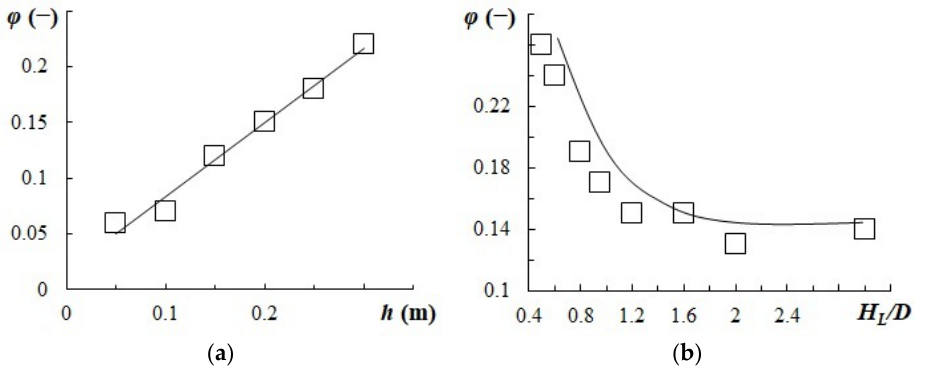
Figure 10. Dependence of gas content on paddle height ( a ) and the ratio H L / D ( b ) at H L / D = 1.2, D = 0.28 (m), n = 1400 (rpm), b = 0.025 (m), d s = 0.065 (m), h = 0.3 (m).